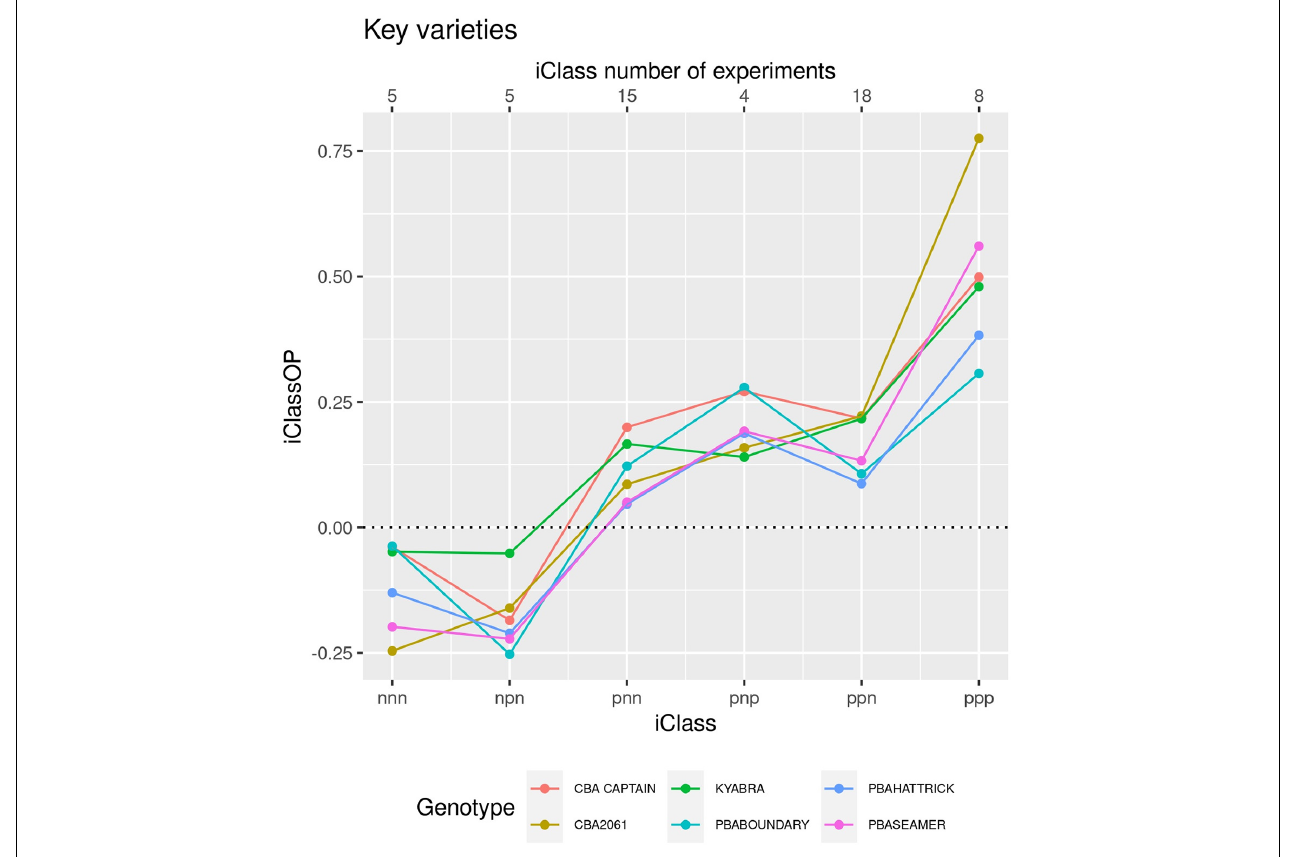
FIGURE 5 | iClass interaction plot for the breeding line CBA2061 and comparison with five regionally adapted